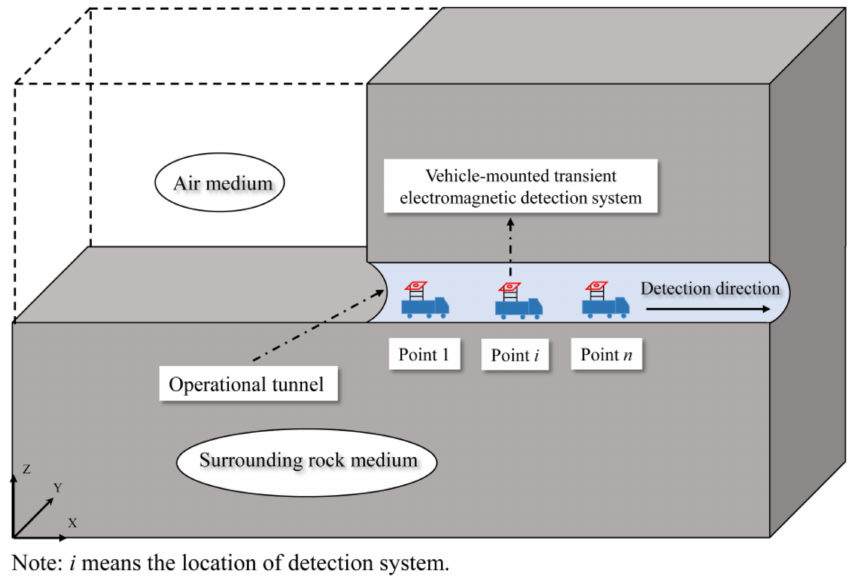
Figure 1. Schematic diagram of the vehicle-mounted transient electromagnetic detection